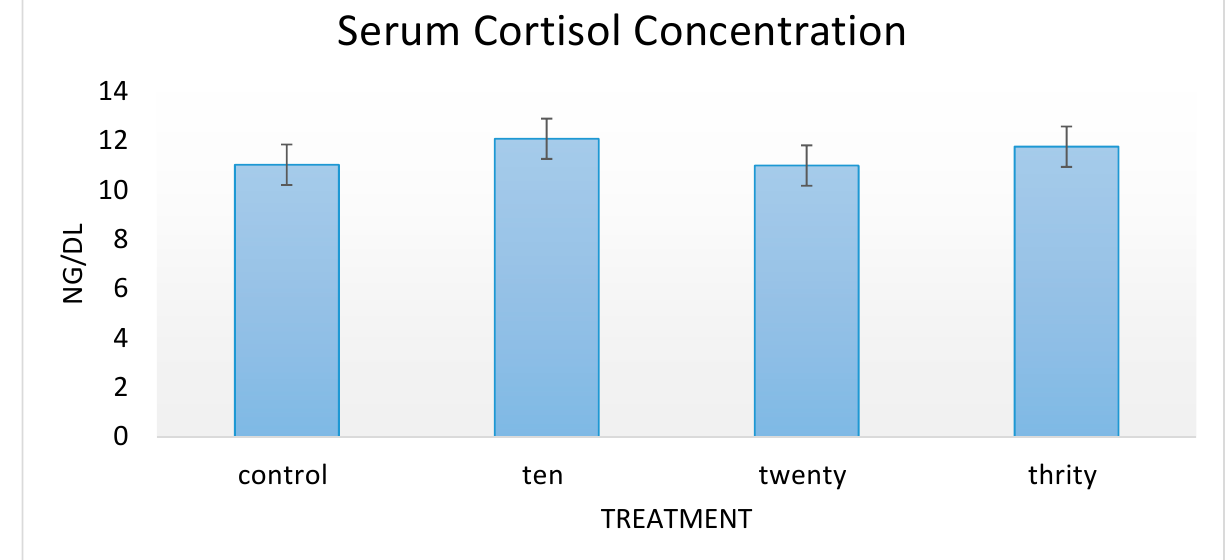
Figure 2. Serum cortisol concentration on day 60 of feeding period.